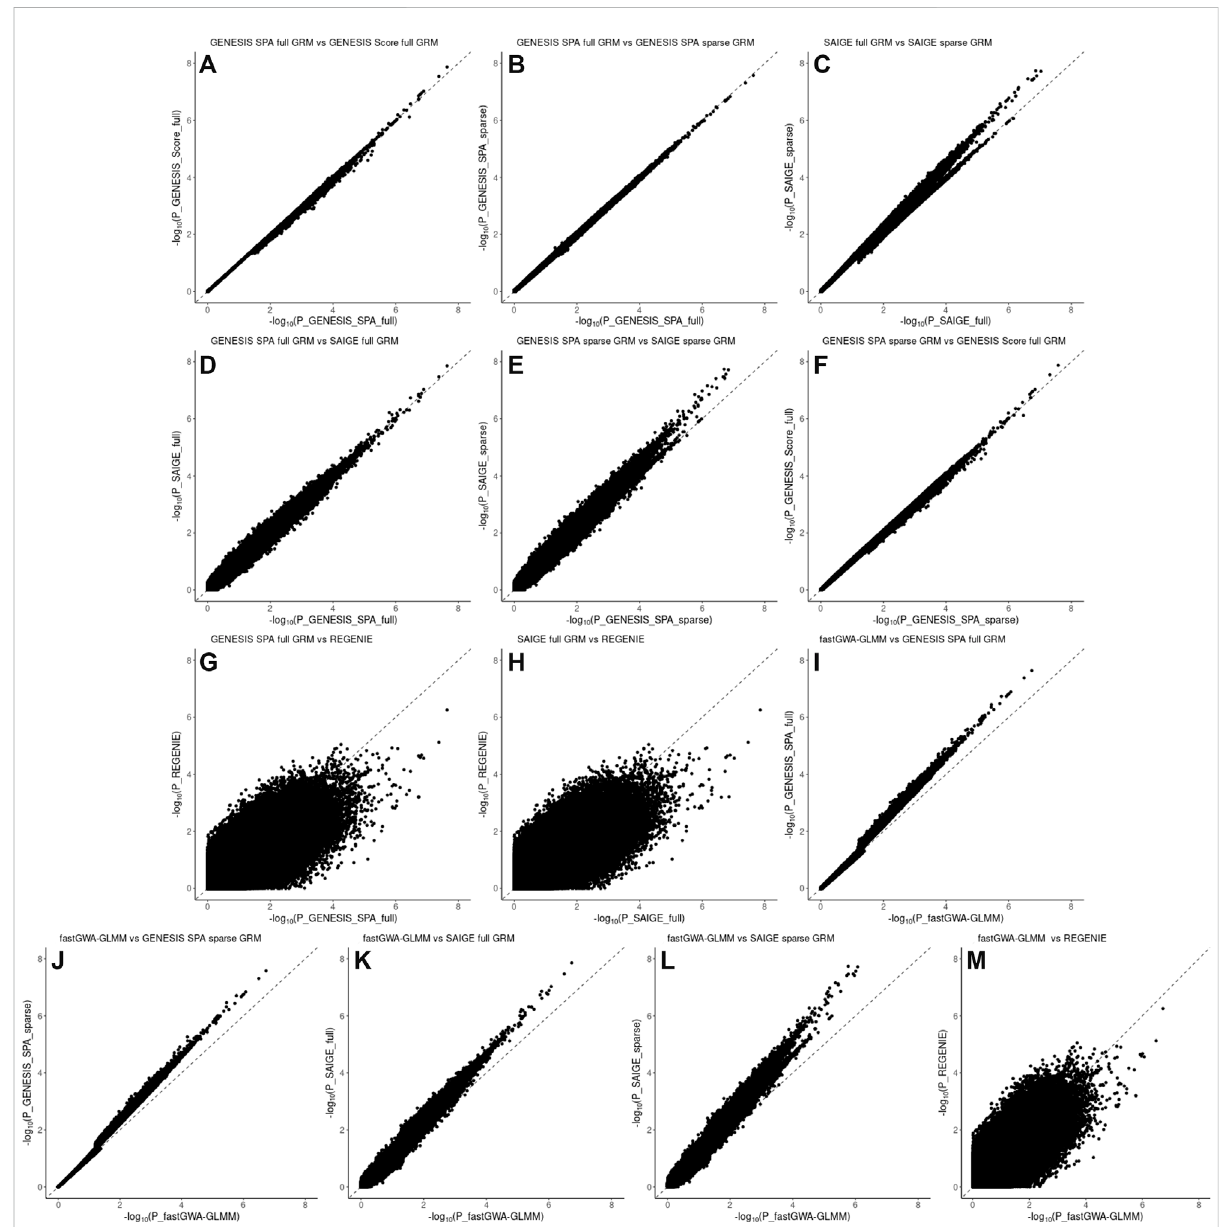
FIGURE 4 Pairwise comparison plots of – log10(pvalues) for the associations using WGS data in the LLFS data. Panel (A) : comparison of the associations based on the SPA and adjusted for the full genetic relation matrix (GRM) using GENESIS on the X axis versus associations based on the score test and adjustedforthefullGRMusingGENESISonthe Y axis.Panel (B) :comparisonoftheassociationsbasedontheSPAandadjustedforthefullGRMusing GENESISonthe X axisversusassociationsbasedontheSPAandadjustedforthesparseGRMusingGENESISonthe Y axis.Panel (C) :comparison of the associations based on the SPA and adjusted for the full GRM using SAIGE on the X axis versus associations based on the SPA and adjusted for the sparse GRM using SAIGE on the Y axis. Panel (D) : comparison of the associations based on the SPA and adjusted for the full GRM using GENESIS on the X axis versus associations based on the SPA and adjusted for the full GRM using SAIGE on the Y axis. Panel (E) : comparison of the associations based on the SPA and adjusted for the sparse GRM using SAIGE on the X axis versus associations based on the SPA and adjusted for the sparse GRM usingGENESISonthe Y axis.Panel (F) :comparisonoftheassociationsbasedontheSPAandadjustedforthesparseGRMusingGENESISonthe X axis versus associations based on the score test and adjusted for the full GRM using GENESIS on the Y axis. Panel (G) : comparison of the associations based on the SPA and adjusted for the full GRM using GENESIS on the X axis versus associations based on the SPA and polygenic effect estimates to control for relatedness using REGENIE on the Y axis. Panel (H) : comparison of the associations based on the SPA and adjusted for the full GRM using SAIGEonthe X axisversusassociationsbasedontheSPAandpolygeniceffectestimatestocontrolforrelatednessusingREGENIEonthe Y axis.Panel (I) : comparison of the associations based on the SPA and adjusted for the full GRM using fastGWA-GLMM on the X axis versus associations based on theSPAandadjustedforthefullGRMusingGENESISonthe Y axis.Panel (J) :comparisonoftheassociationsbasedontheSPAandadjustedforthefull GRM using fastGWA-GLMM on the X axis versus associations based on the SPA and adjusted for the sparse GRM using GENESIS on the Y axis. Panel (K) :comparison oftheassociations basedon theSPAandadjusted for thefullGRMusing fastGWA-GLMMon the X axisversusassociationsbased on the SPA and adjusted for the full GRM using SAIGE on the Y axis. Panel (L): comparison of the associations based on the SPA and adjusted for the full GRMusing fastGWA-GLMMon the X axis versusassociations based on theSPAand adjusted for thesparseGRMusing SAIGE onthe Y axis. Panel (M): comparison of theassociationsbased on theSPA and adjusted for thefull GRM usingfastGWA-GLMM on the X axis versusassociations basedon the SPA and polygenic effect estimates to control for relatedness using REGENIE on the Y